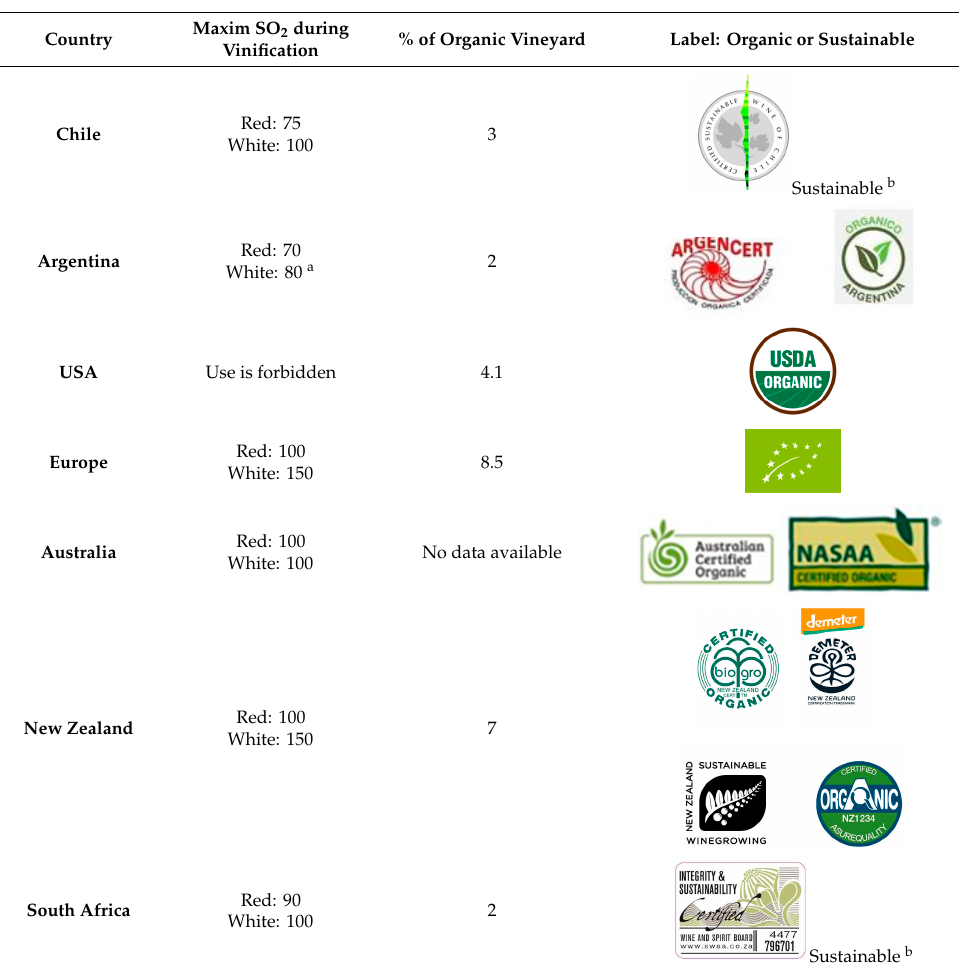
a 100 mg/L in aged wines; b no specific label for organic wines.